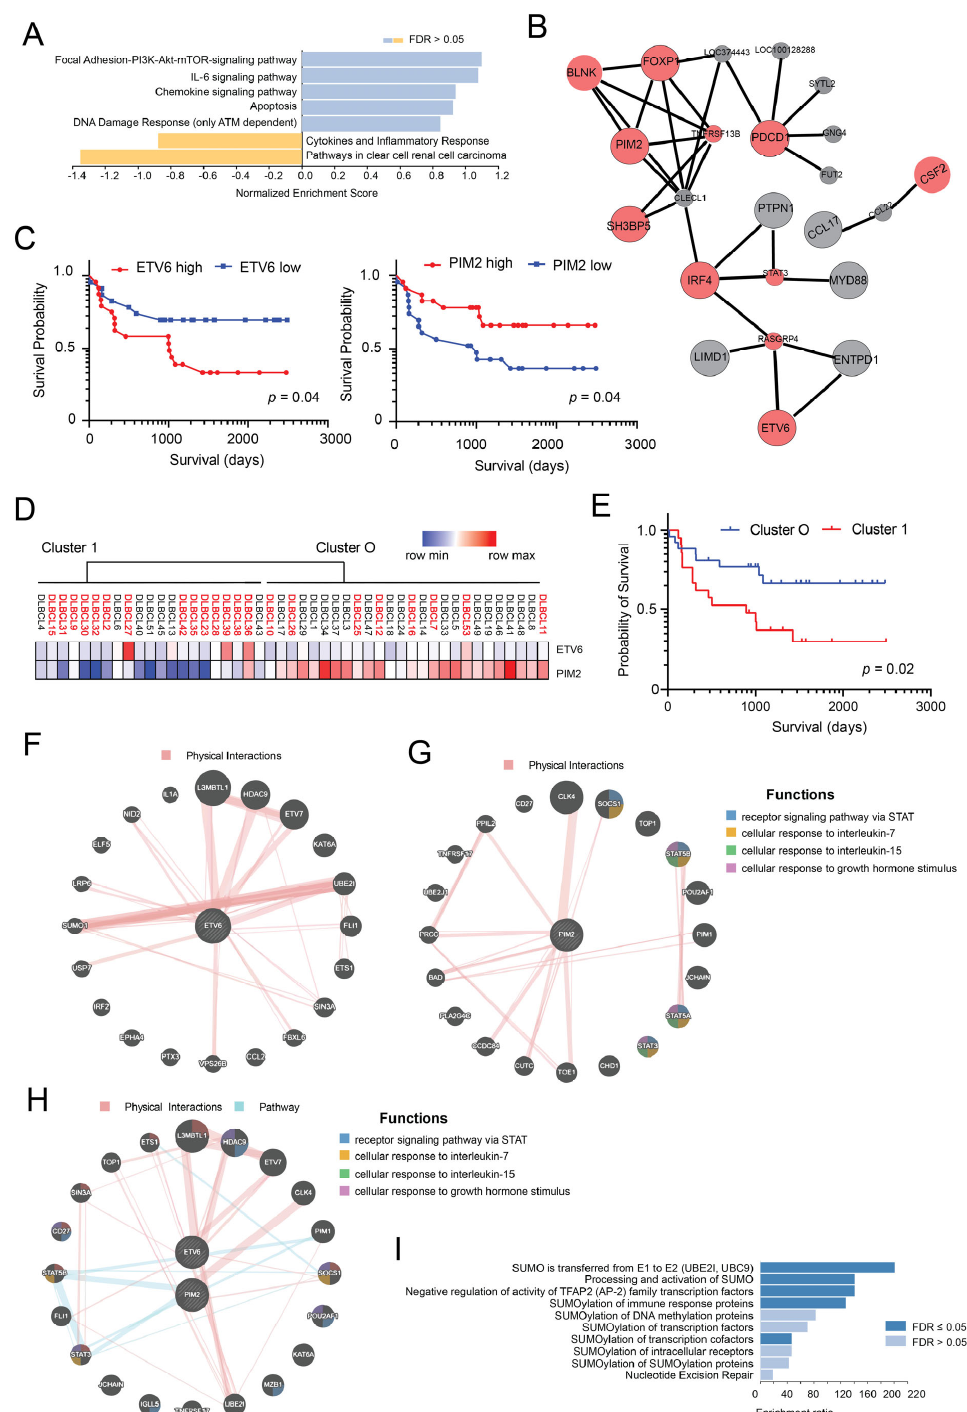
Figure 2. Identification of proteins associated with survival through univariate and multivariate Cox regression analysis. ( A ) The list of proteins identified as associated with survival through univariate Cox regression analysis ( n = 41) was used for Gene Set Enrichment Analysis (GSEA) using WEB-based GEne SeT AnaLysis Toolkit (WebGestalt) with Wikipedia cancer pathway as enrichment categories. The enriched categories are shown. ( B ) Network topology-based analysis for the same list of proteins was run using TCGA RNA Seq data for DLBCL samples as the functional database. The identified network was found to be enriched for numerous Gene Ontology (GO) categories, including immune system development (proteins included in this subnetwork are shown). ( C ) Kaplan–Meier curves